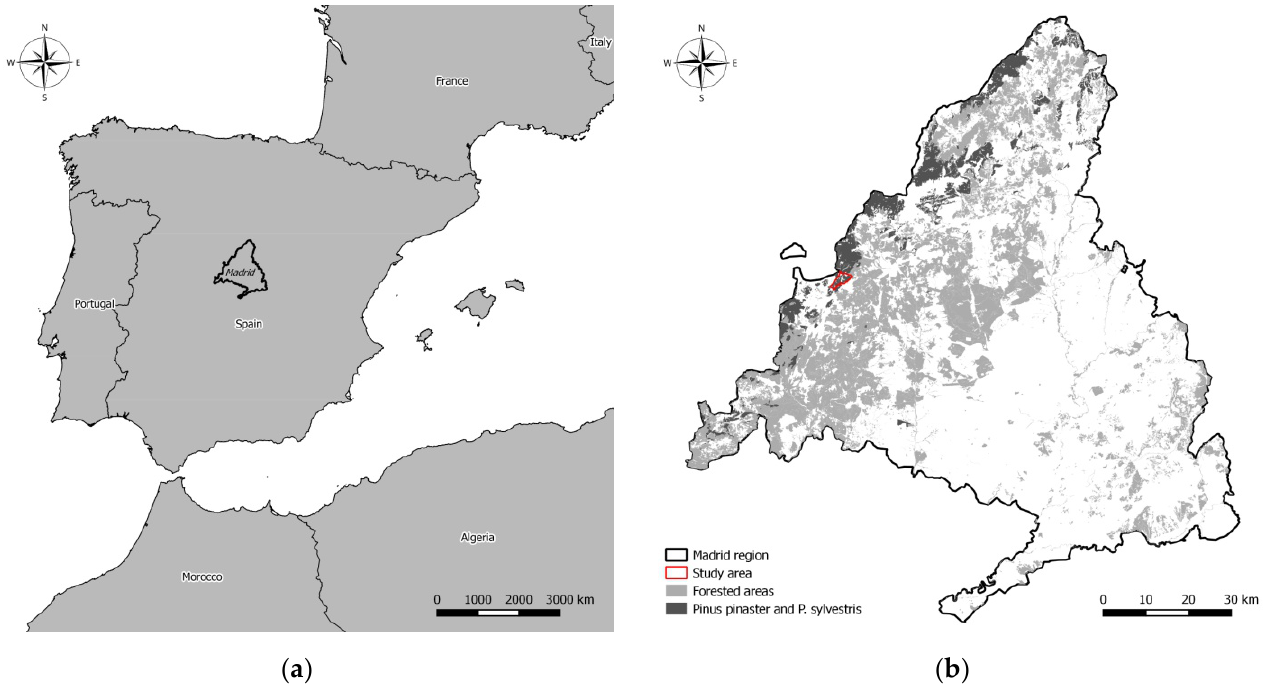
Figure 1. Study area. ( a ) Situation of Madrid Region in the Western Mediterranean; ( b ) Forested areas of Madrid Region, Pinus pinaster and P. sylvestris stands, and study area.